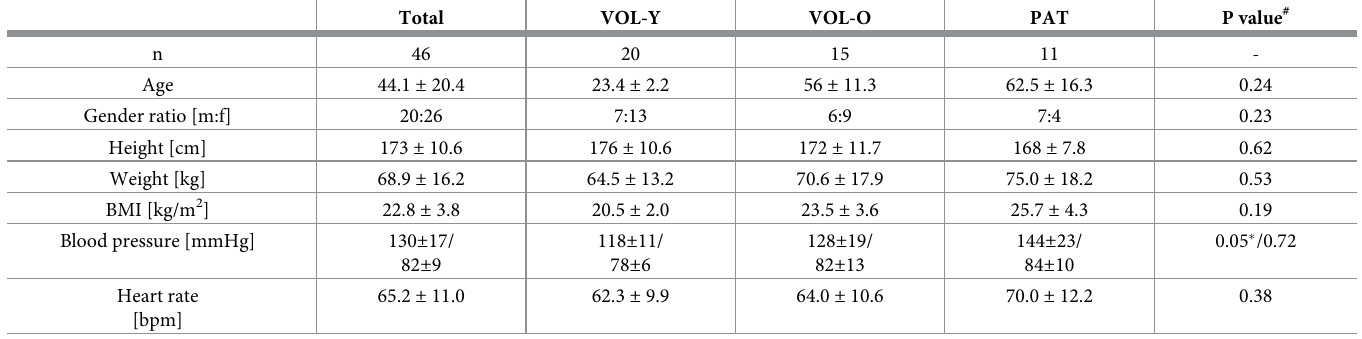
Table 1. Demographics and physiological data.